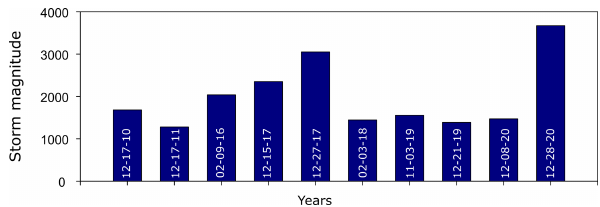
Figure 5. The magnitude of storms lasting more than 6h during the observation period (2010–2020) from 202–242 ◦ directions with a velocity higher than